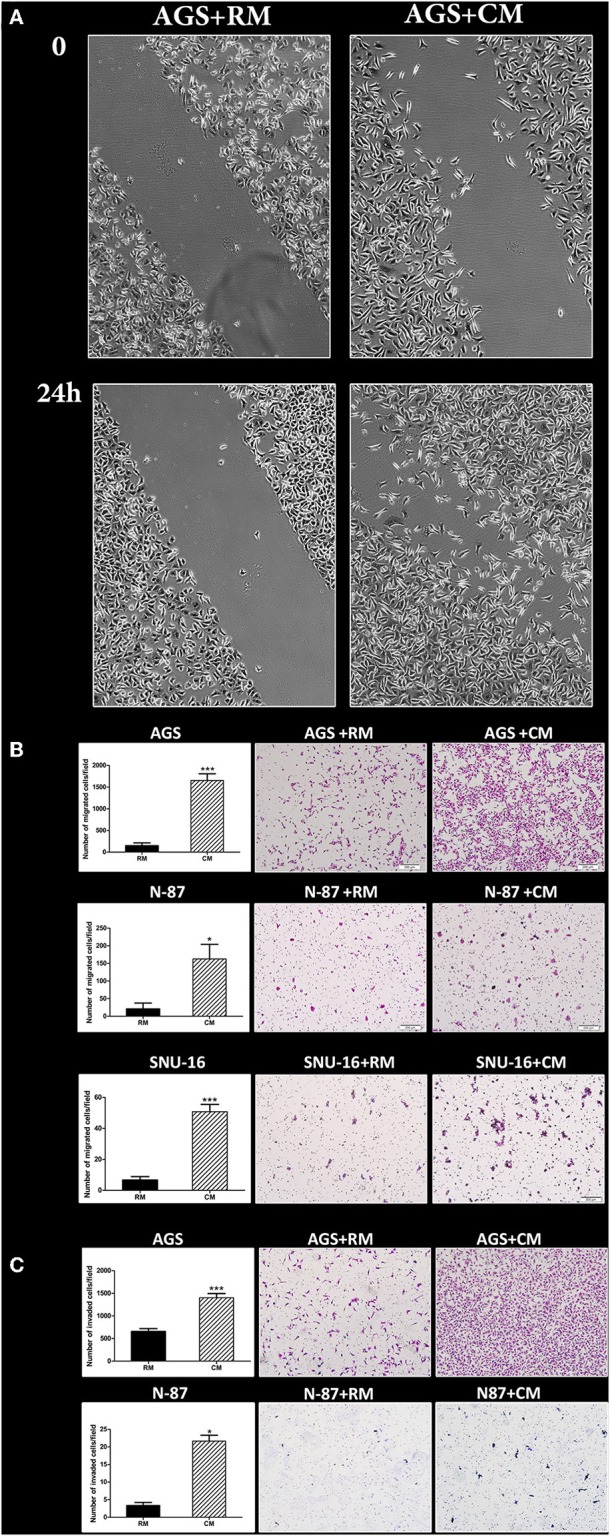
Omental tissue CM augments gastric cancer cell migration and invasion. (A) Scratch wound healing assay displaying the effect of omental tissue CM on AGS cells migration; Scale bar = 200 μm; (B) Transwell assays demonstrating the effects of omental tissue CM on gastric cancer cell migration (P < 0.05); (C) Matrigel invasion chamber assay showing a significant increase in invasion of AGS and N-87 cells. Omental tissue CM was used as chemoattractant (P < 0.05); Left panel graphs represent the average of 5 repeated experiments ± SD, and the right panel depicts representative images (magnification, ×100). *P < 0.05; ***P < 0.001.